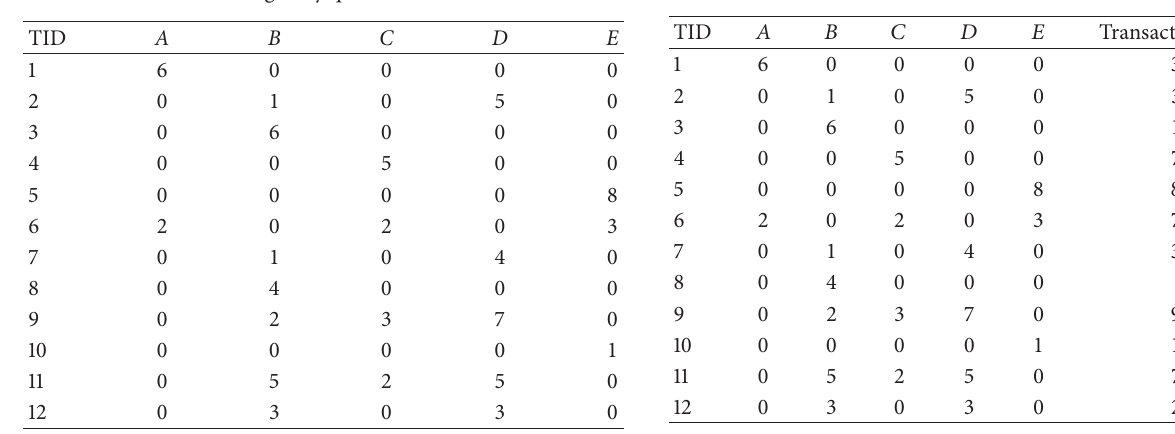
Table 2: An originally quantitative database.